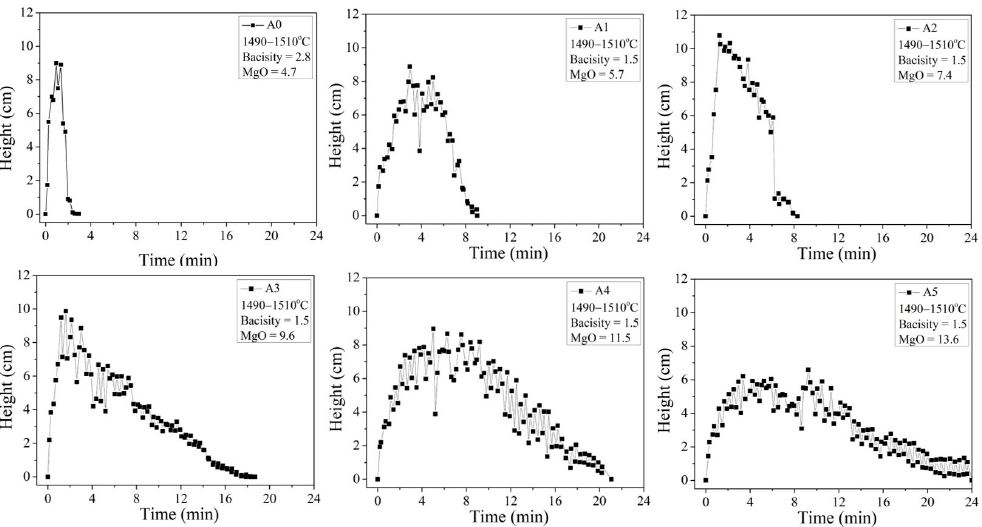
Figure 6. Foaming height and foaming life tests of A0–A6.